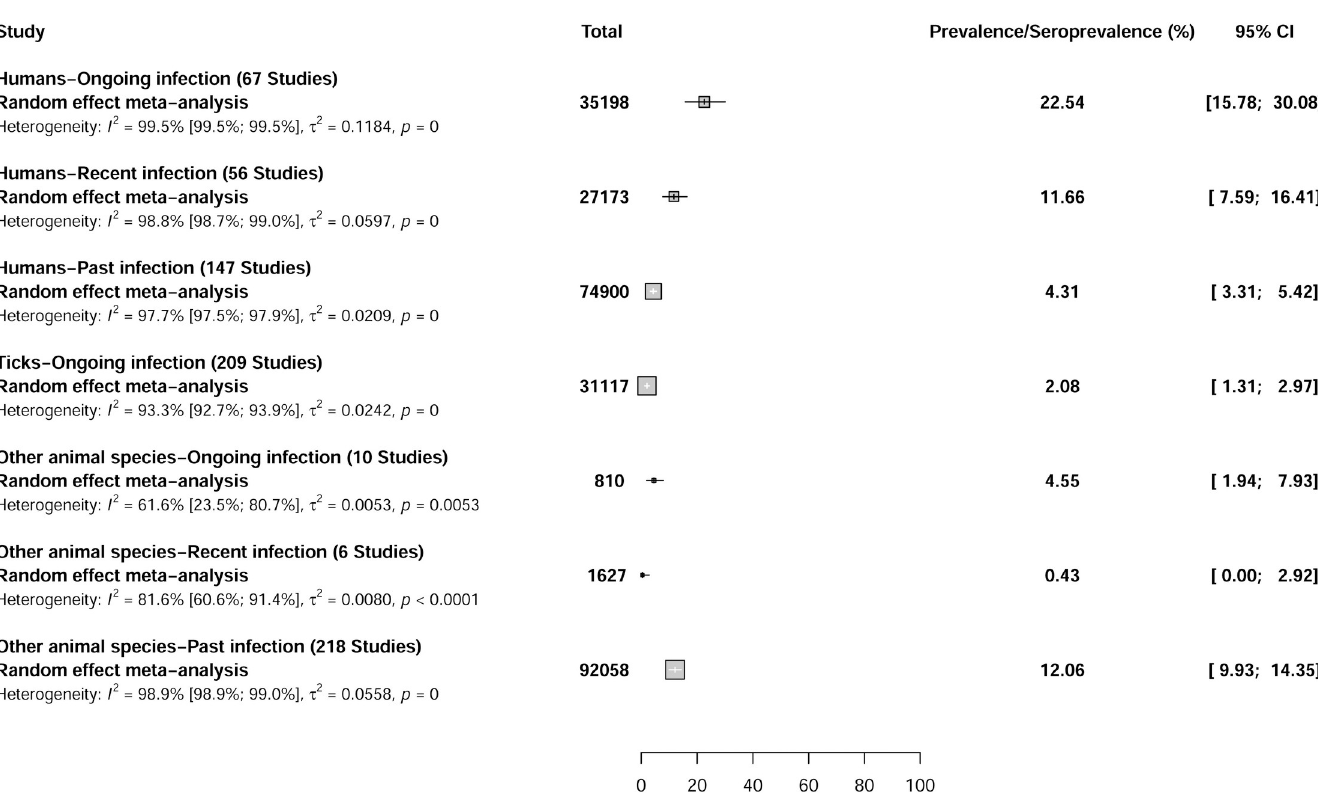
PLOS NeglectedTropical Diseases | https://doi.org/10.1371/journal.pntd.0009299 April 22, 2021 8 /